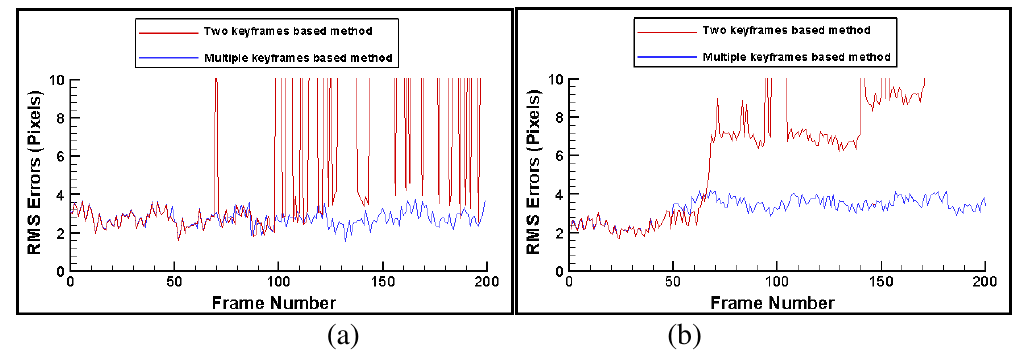
Figure 13. Comparison of RMS